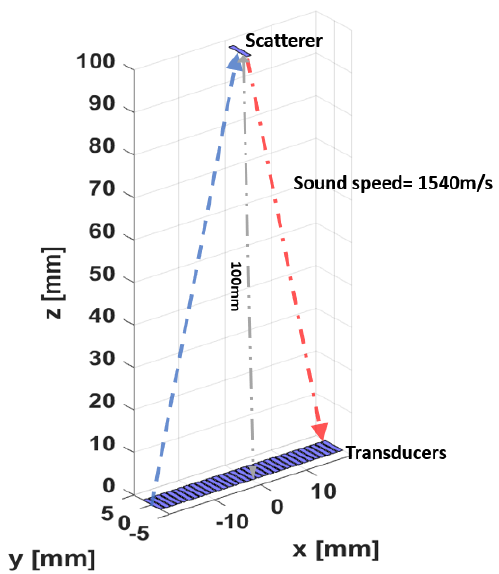
Figure 5. The simulation setup.